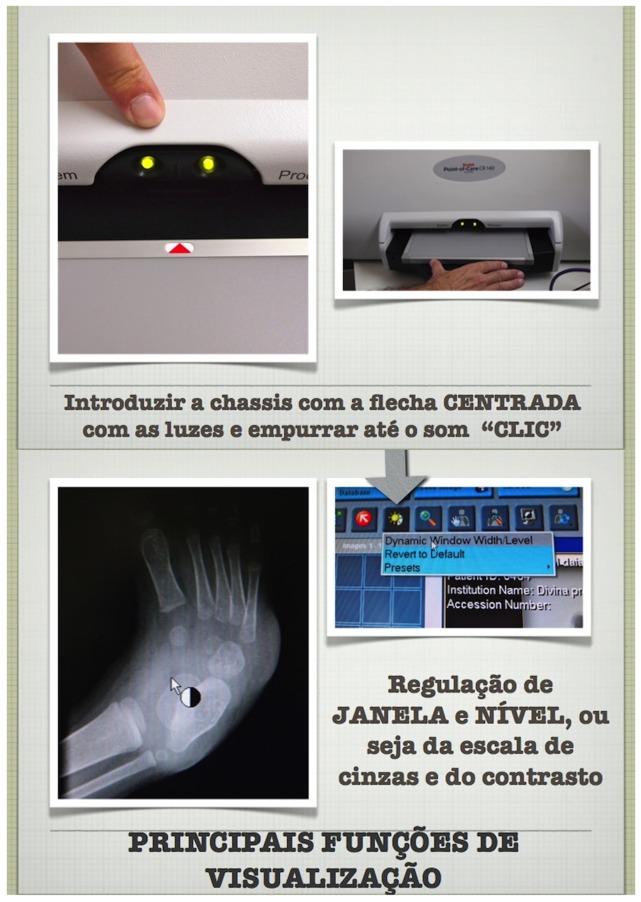
Extract from the training course.Note: This extract from the training course in Portuguese, the national language in Angola, shows how to initiate the system (upper images), and how to choose functions to optimise X-ray visualisation (lower images).